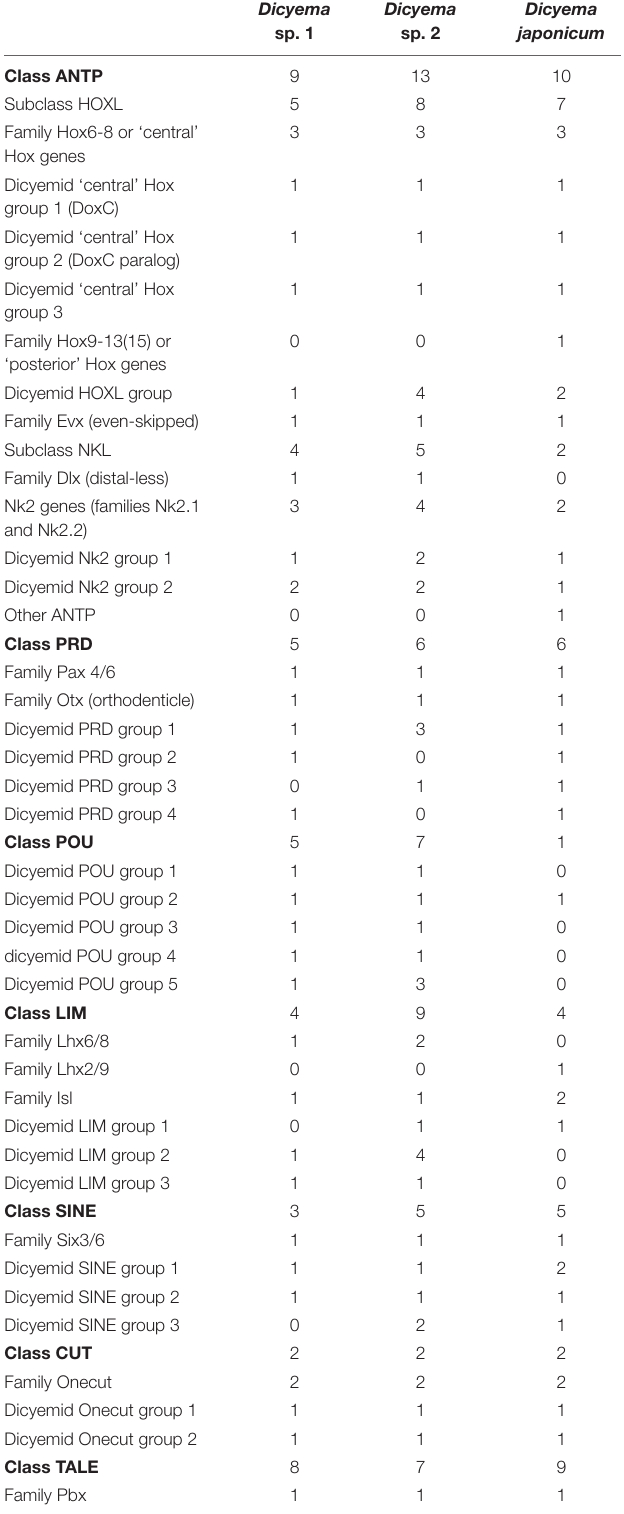
Dicyema Dicyema sp. 1 sp.